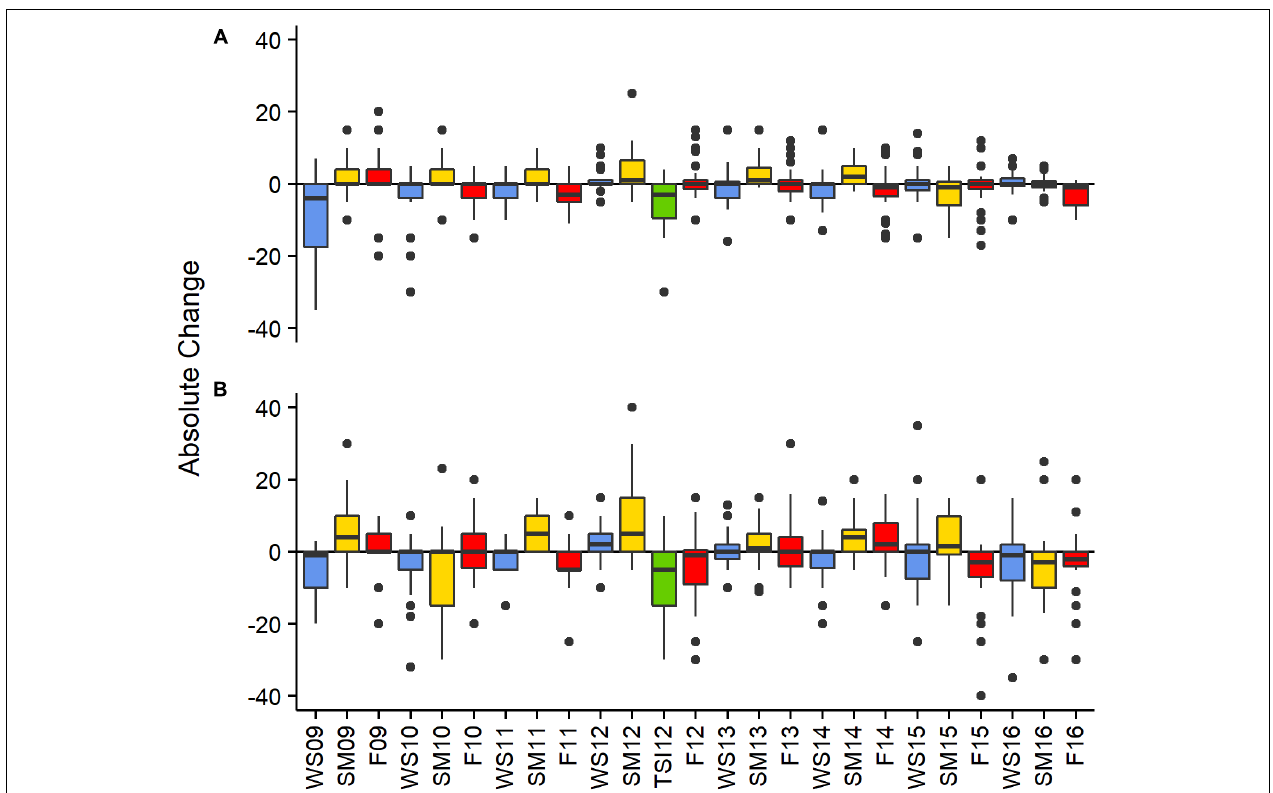
FIGURE 2 | Absolute change in percent cover between monitoring events by site BCA (A) , Scooter (B) . Colors represent seasonal changes from Fall to Winter—blue, Winter to Summer—yellow, and Summer to Fall—red, the green bar represents change in cover between the SM12 and the TSI12 monitoring events. Boxes represent the 25 and 75% quartiles with whiskers extending 1.5 ∗ interquartile range, the line represents the median, and dots are considered